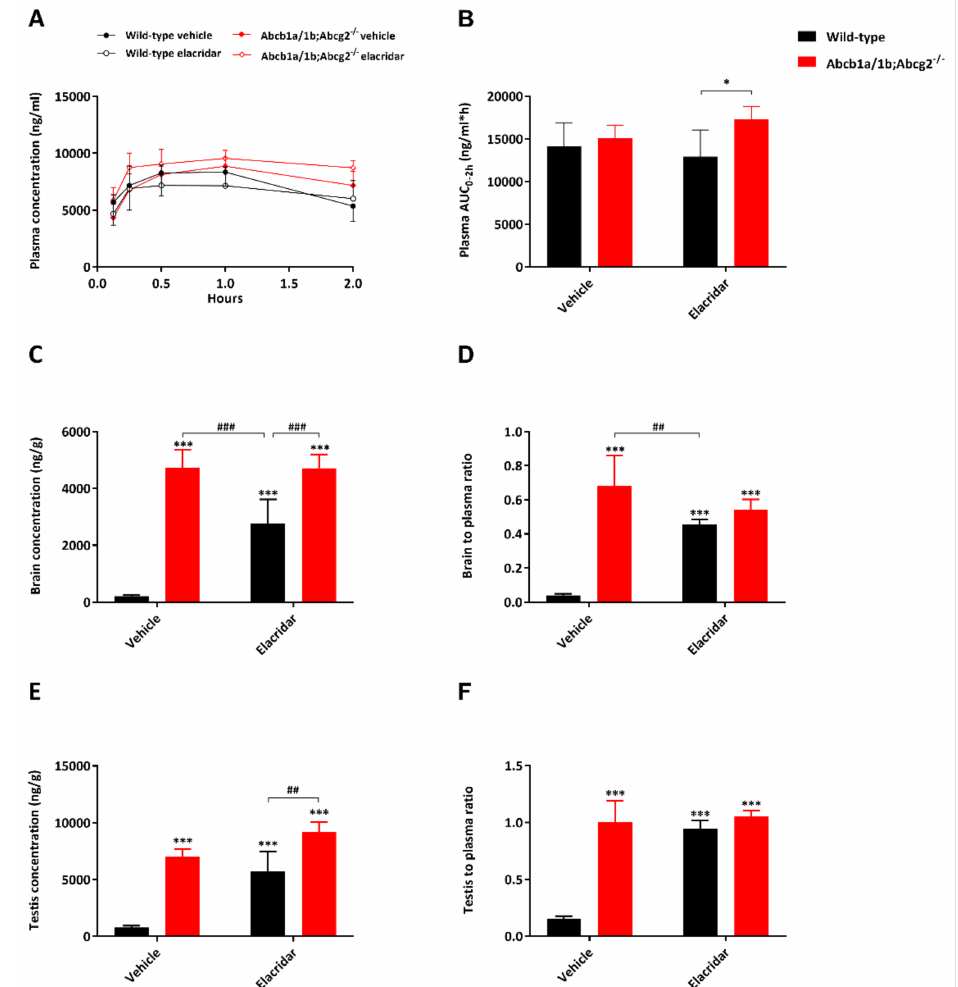
Figure 7. Plasma concentration–time curves ( A ), plasma AUC 0–4h ( B ), brain concentration ( C ), brain- to-plasma ratio ( D ), testis concentration ( E ) and testis-to-plasma ratio ( F ) of selpercatinib in male wild-type and Abcb1a/1b;Abcg2 -/- mice over 2 h after oral administration of 10 mg/kg selpercatinib with or without coadministration of elacridar. Data are given as mean ± S.D. (n = 6). *, p < 0.05; **, p < 0.01; ***, p < 0.001 compared to vehicle-treated wild-type mice; #, p < 0.05; ##, p < 0.01; ###, p < 0.001 compared to elacridar-treated wild-type mice. Statistical analysis was applied after log-transformation of linear